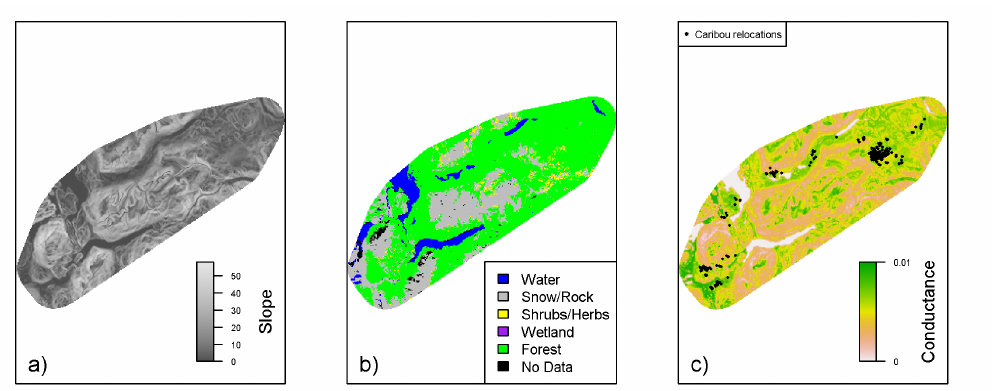
Figure 9: Data used in caribou example: a) slope (degrees) derived from a digital elevation model (DEM) of the study area, b) land cover data for the study area, and c) the derived conductance